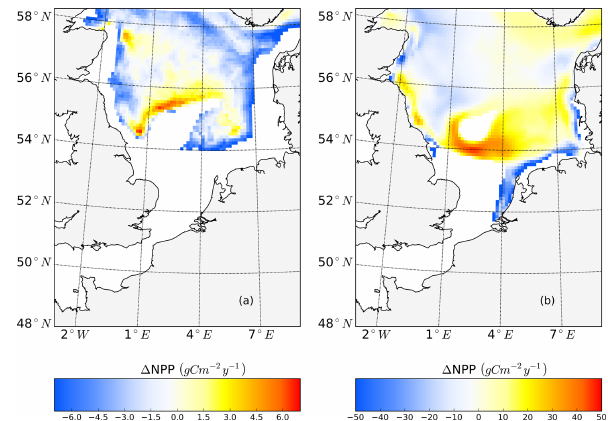
Figure 8. Mean difference in the NPP between the tidal and non- tidal scenarios generated within the SBM layer (a) and in the surface layer (above 15m) (b) . The results are averaged for the stratified season. Areas with SBM mean occurrences of less than 10d per year are excluded in panel (a) . Areas with stratification (squared buoyancy frequency N 2 > = 0 . 013 (s − 2 ) averaged less than 60d per year are excluded in panel (b)